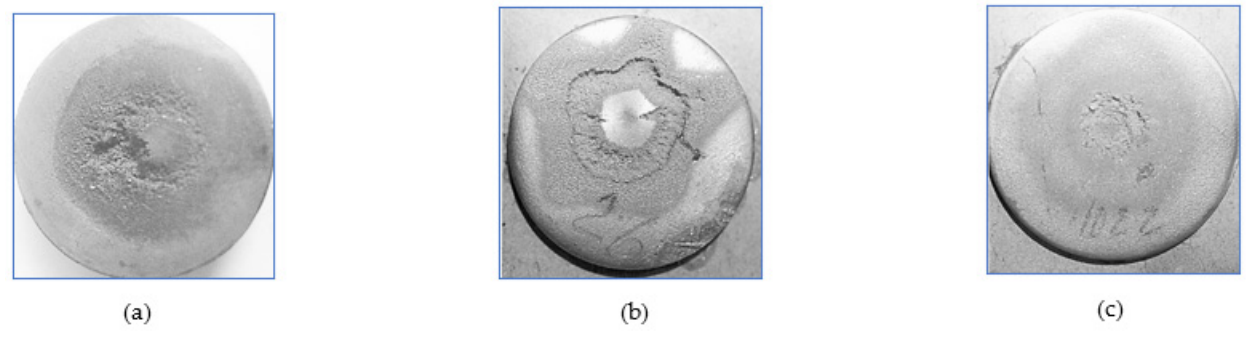
Figure 10. Erosion pattern on aluminum plates. ( a ) Pressure in the test chamber is atmospheric, ( b ) pressure in the test chamber is 10 atm, ( c ) pressure in the test chamber is 30 atm.